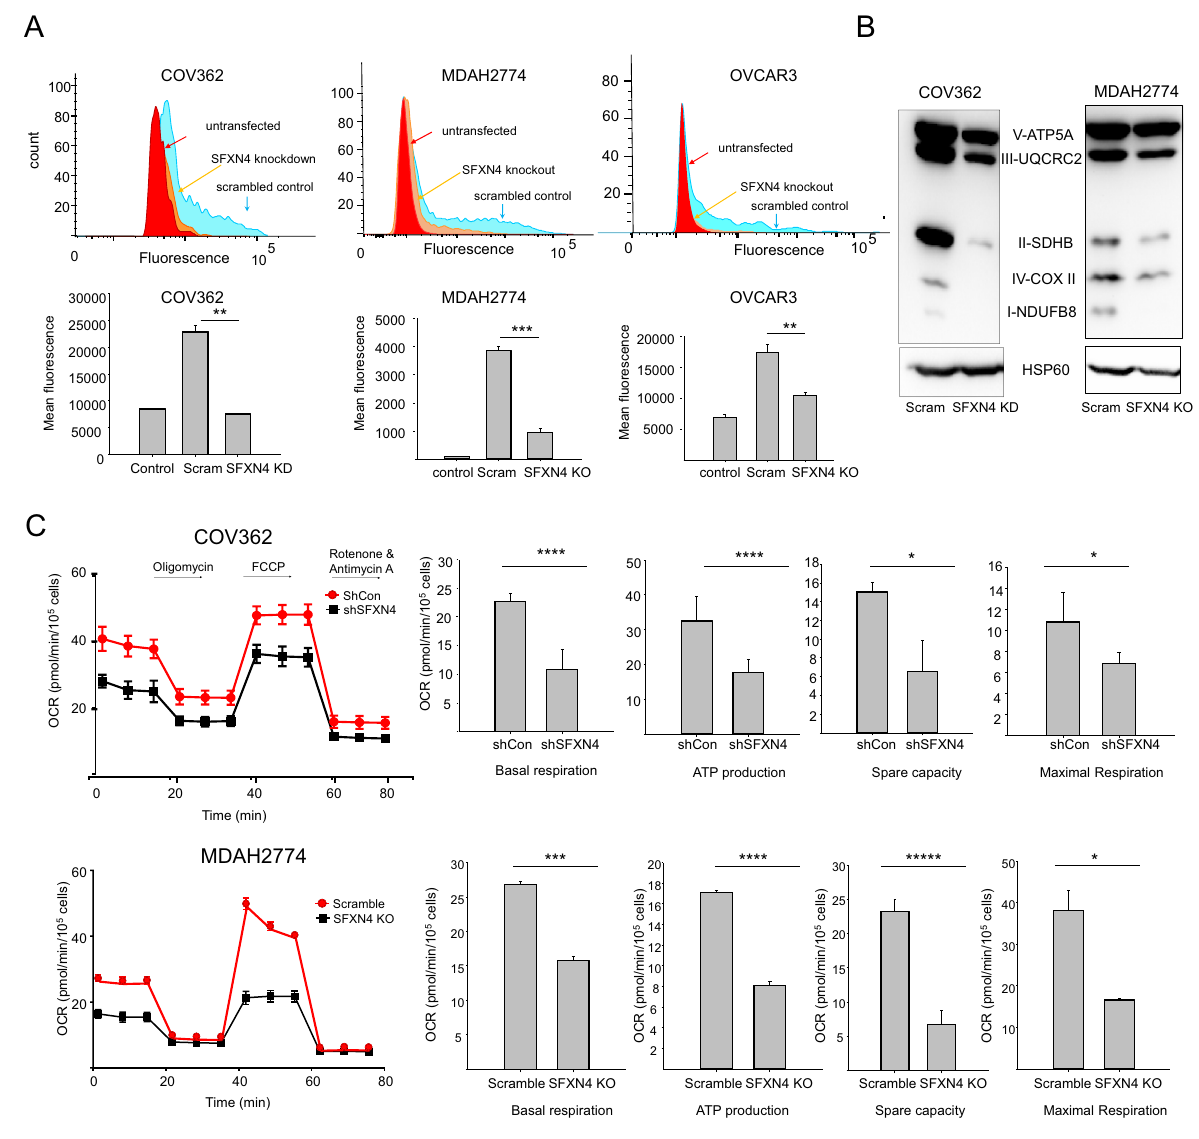
Figure 2. Depletion of SFXN4 reduces Fe-S cluster assembly, mitochondrial respiratory complex proteins, and mitochondrial respiration. ( A ) Relative fluorescence of GRX2-Fe-S dependent sensors in untransfected, scrambled controls, and SFXN4 knockdown COV362, MDAH2774 and OVCAR3 cells. Panels below are quantification of mean fluorescence intensity in three independent Fe-S cluster formation experiments with **p < 5.6E−04; ***p < 1.3E−05. ( B ) Western blots showing levels of labile subunits from each of the five mitochondrial respiratory complexes in COV362 and MDAH2774 SFXN4 KO and control cells. Uncropped images are presented in Supplemental data (Supplemental Fig. S9). ( C ) Changes in oxygen consumption rate in response to treatment with indicated metabolic inhibitors in COV362 (above) and MDAH2774 (below) SFXN4 KD or SFXN4 KO and control cells. Panels at right show basal respiration, mitochondrial ATP production, maximal respiration, and spare capacity quantified in 3–12 replicate experiments (means and standard deviation with *p < 1.2E−02; ***p < 1.3E−05; ****p < 3.8E−06; ******p <